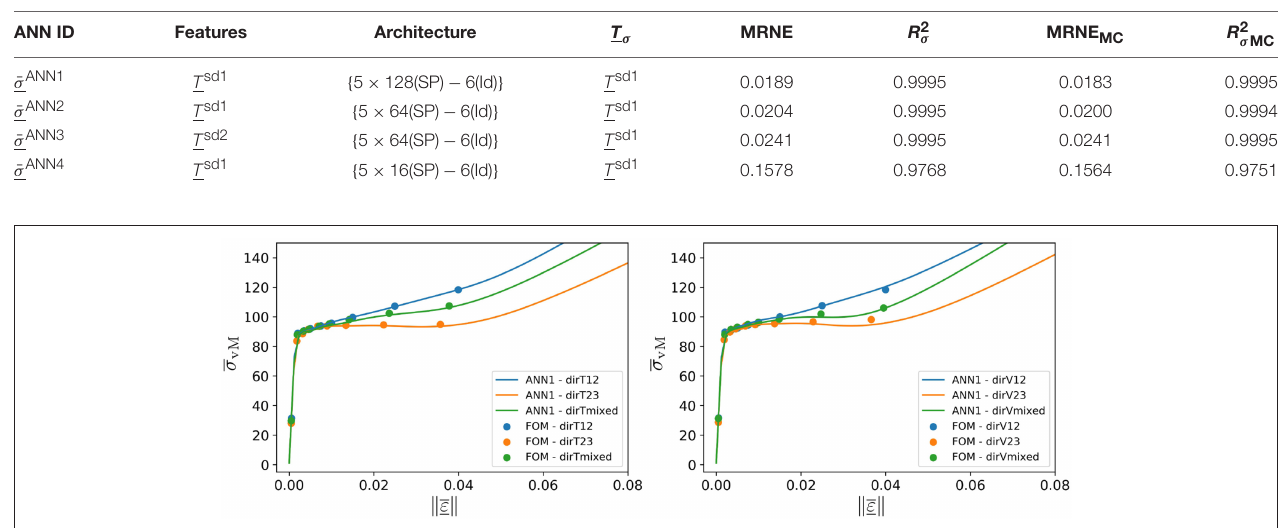
TABLE 1 | ANNs for the effective stress surrogate with corresponding choice of input features, network architecture, intermediate transformation of stress data T σ , measures MRNE and R 2 σ for the validation dataset, and MRNE MC and R 2 σ MC for the MC dataset.